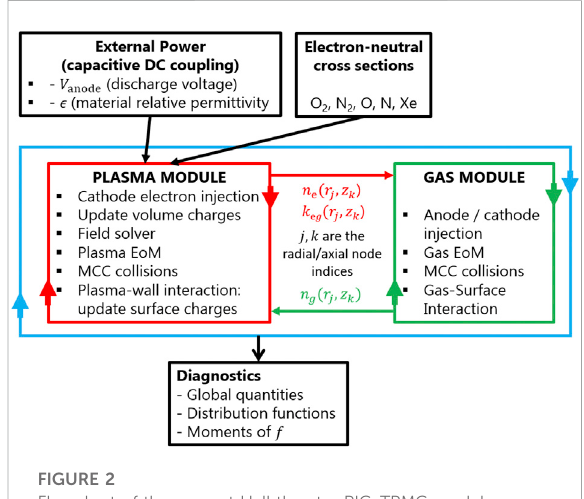
FIGURE 2 Flowchart of the present Hall thruster PIC-TPMC model.